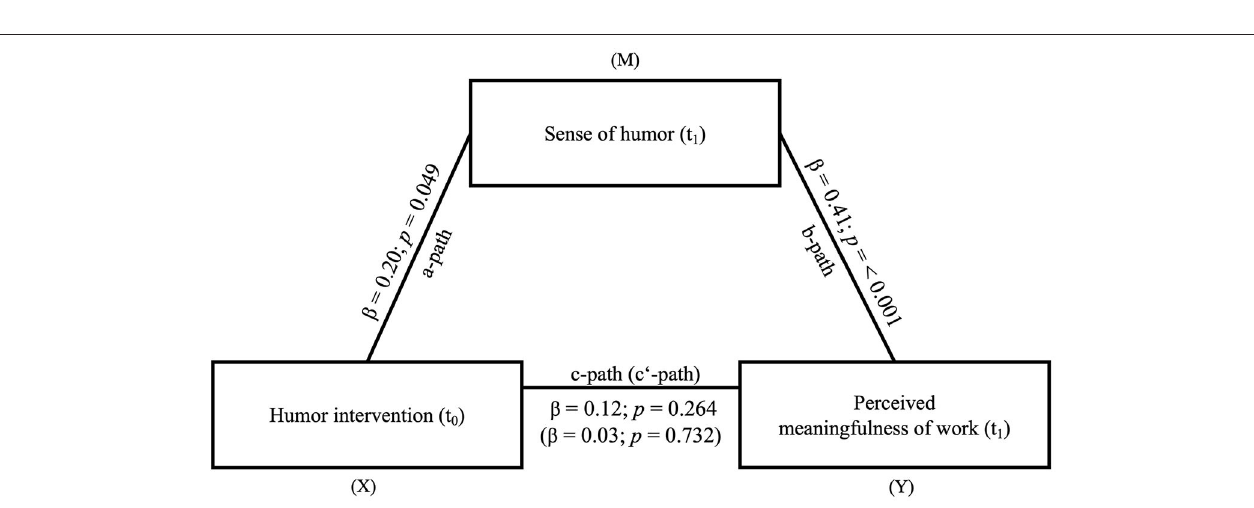
FIGURE 7 | Mediation model of the effect of the humor intervention (X) on perceived meaningfulness of work (Y) via sense of humor (M). N = 94. The indirect effect from (X = independent variable) to (Y = dependent variable) via (M = mediator) was significant ( β = 0.08, SE = 0.04, 0.01 < CI < 0.17); Measuring points: t 0 = Baseline; t 1 = 6 months after the humor